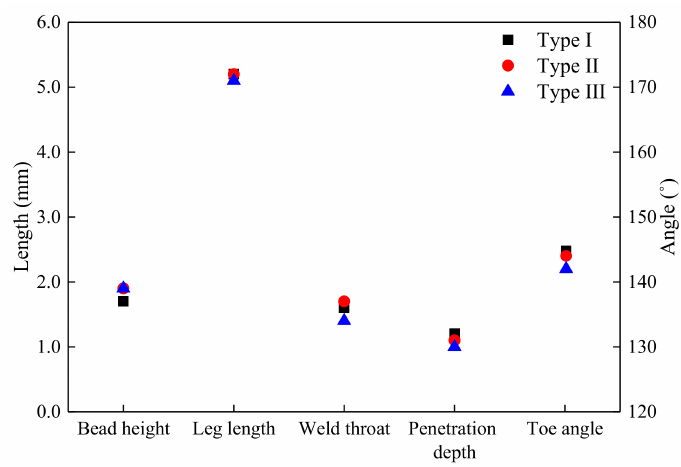
Figure 11. Comparison of weld bead sizes according to weld types using length